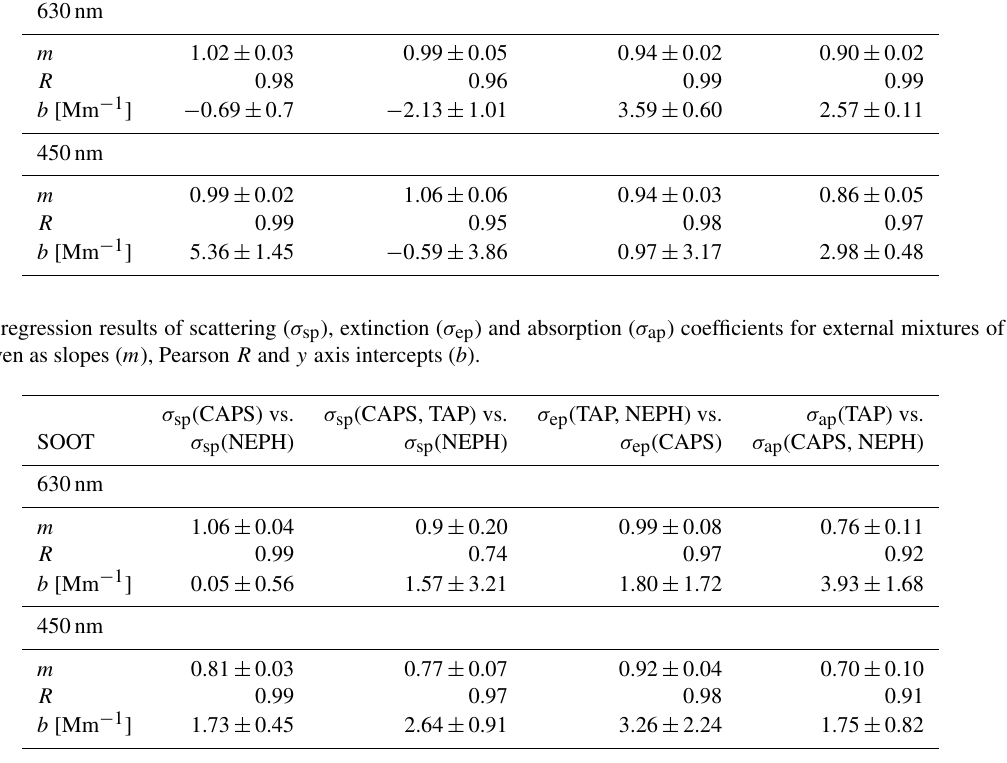
1 . 02 ± 0 . 03 0 . 99 ± 0 . 05 0.98 0.96